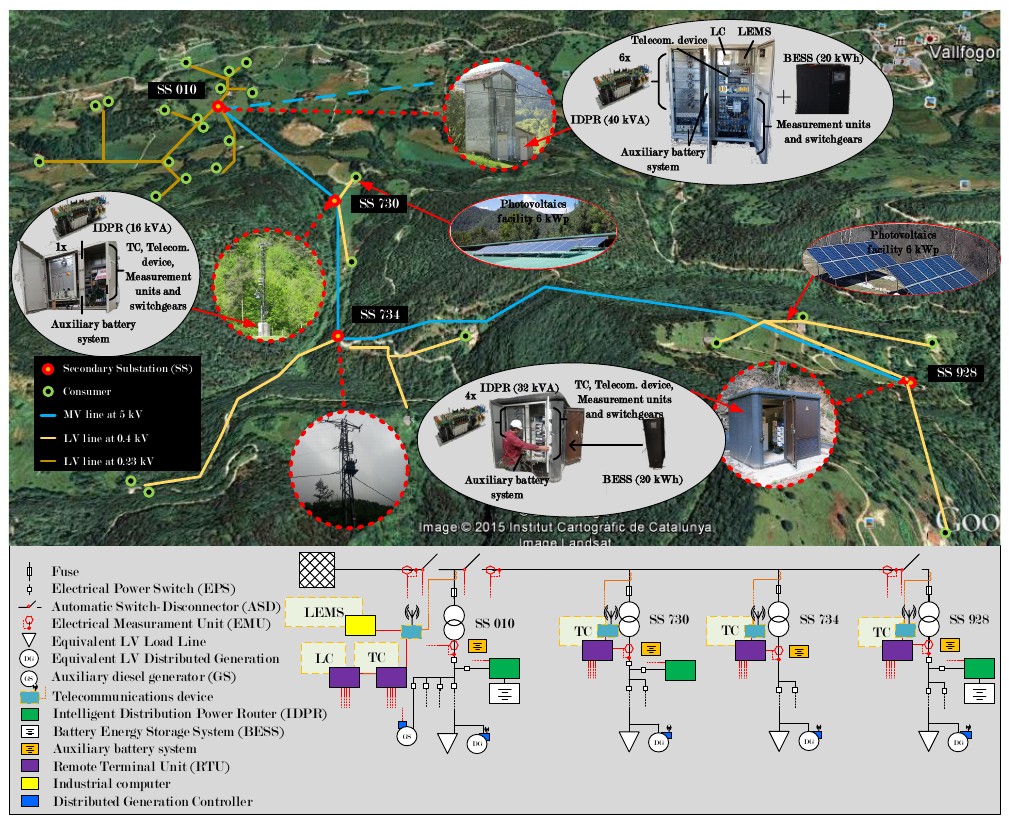
Figure 2. Electrical scheme of Pilot Network with new element after actuations. For the sake of completeness, acronyms not specified in the figure are: Local Energy Management System (LEMS), Local Controller (LC), and Transformer Controller (TC). The whole list of acronyms can be found in abbreviations